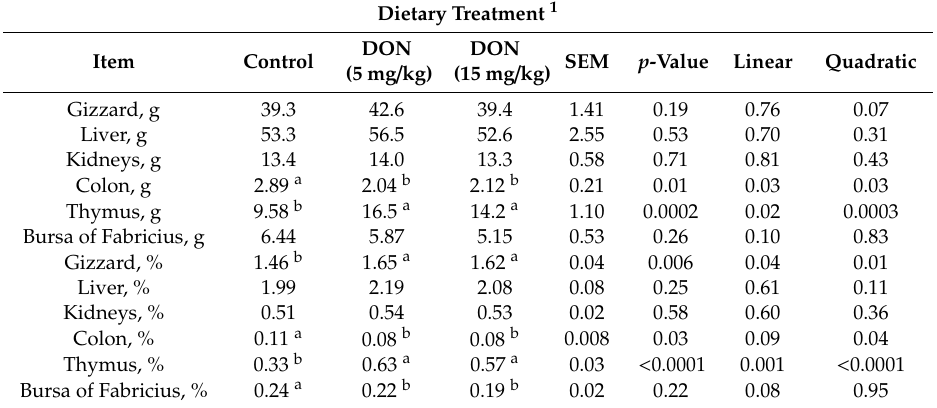
Table 3. E ff ects of DON-contaminated feed (5 and 15 mg / kg) on organ weights of broiler chickens. Dietary Treatment